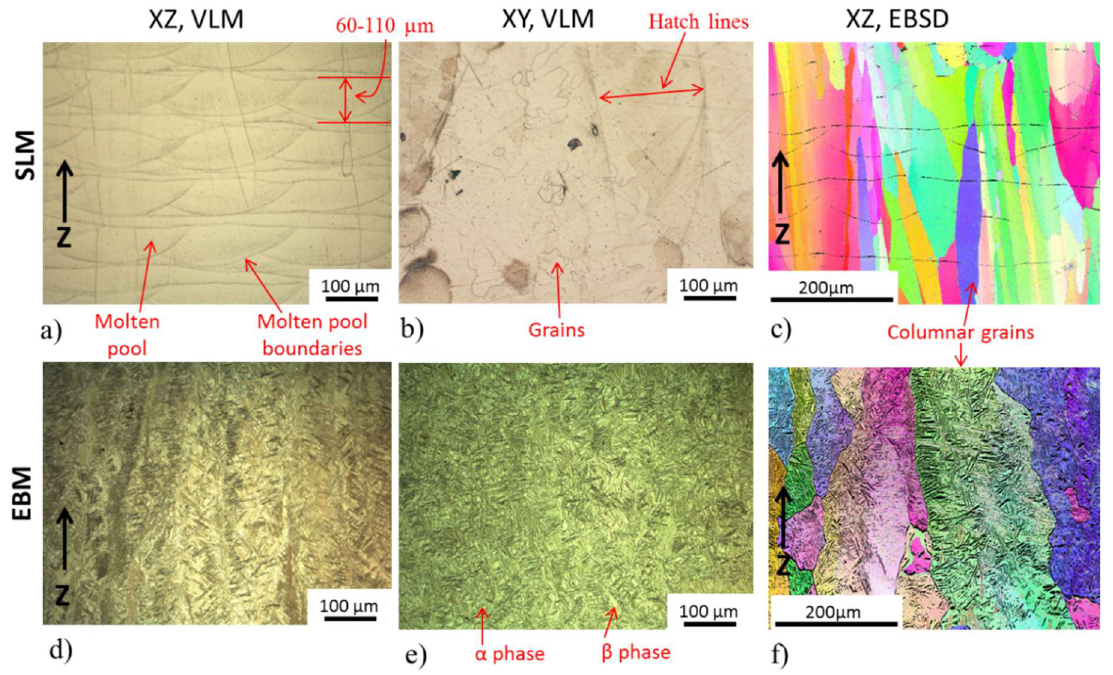
Figure 7. Microstructure of SLM (three images in first / top row) and EBM (all three images in second / bottom row) build samples. ( a , d ) are VLM image from the xz-plane; ( b , e ) are from the xy-plane; ( c , f ) are EBSD pattern from the xz-plane.